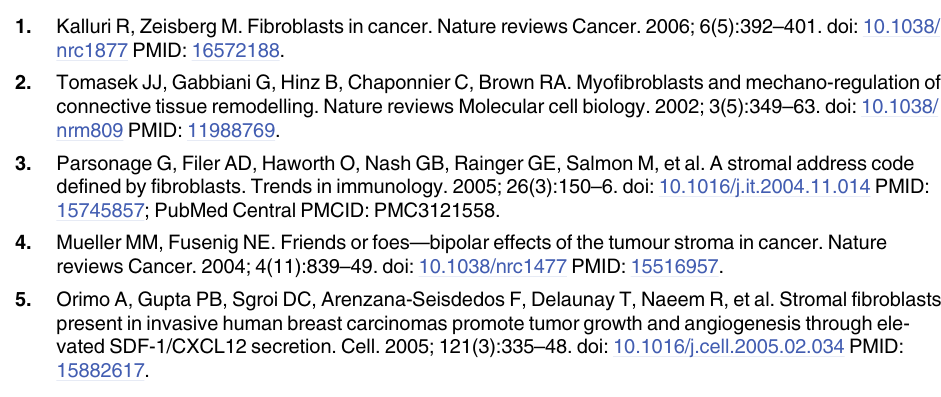
Relative expression levels of miR-1, miR-206, and miR-31 in each group of tumors were deter- mined by Taqman qRT-PCR assay and normalized to U6 levels. S12 Fig. The expression levels of CCL2 and VEGFA in each group of tumors. Relative expression levels of CCL2 and VEGFA in each group of tumors (n = 10) were determined by ELISA kit. S1 Table. Sequences of DNA oligonucleotides used in this